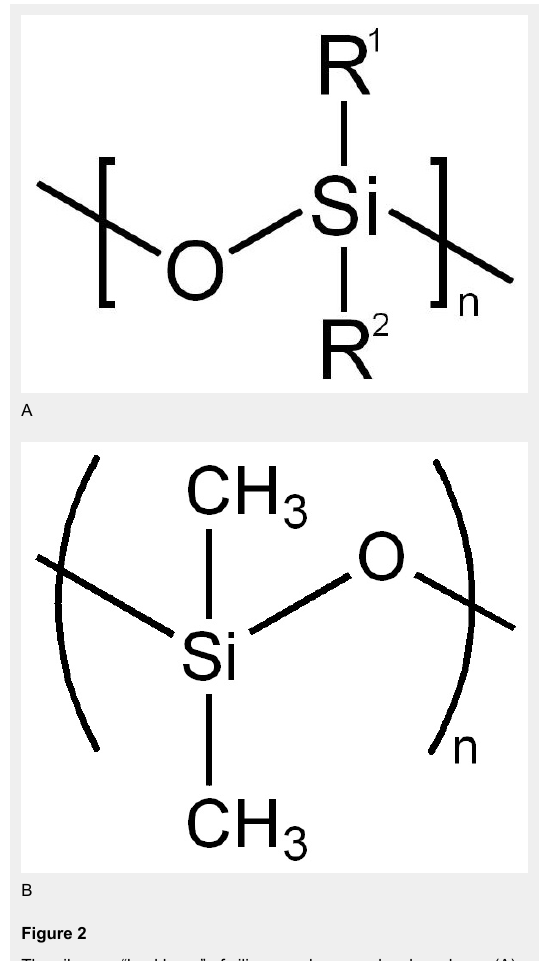
The siloxane “backbone” of silicone polymer molecules, shown (A) generically and (B) specifically with methyl (CH 3 ) groups attached to produce the most common siloxane, polydimethylsiloxane (PDMS). This is the siloxane used to form both the silicone rubber and the silicone gel used in breast implants. Other organic groups can be attached instead of methyl to produce other siloxanes with other properties. Source: Wikimedia Commons.